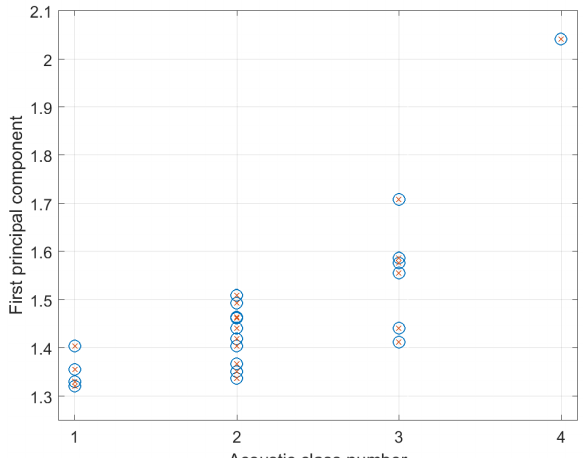
Figure 13. Acoustic class numbers versus first principal component obtained from grain size statistics given by [28].